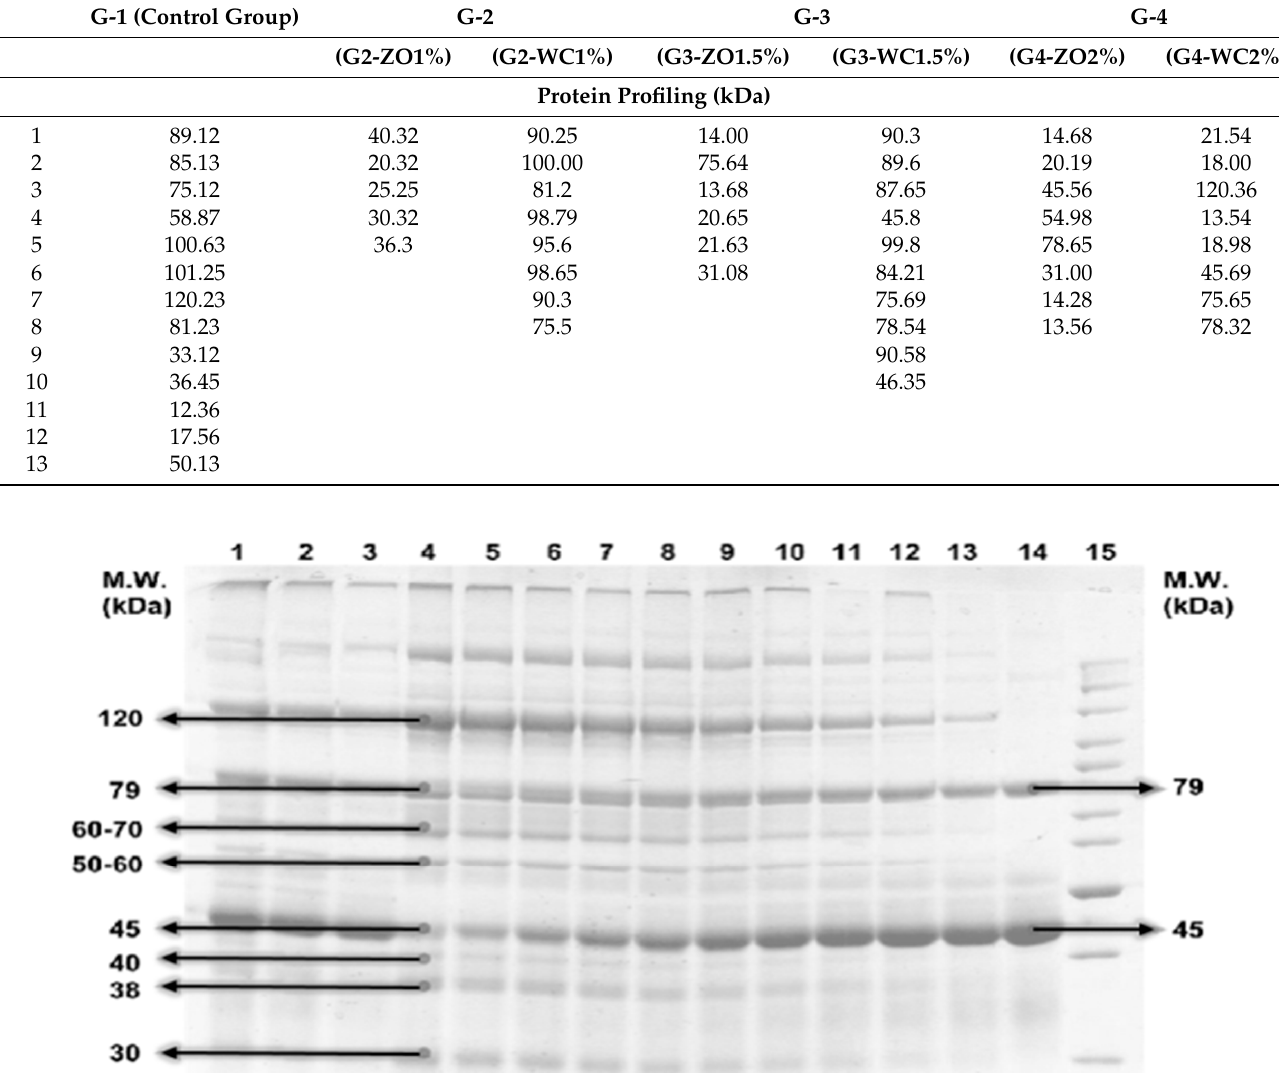
Table 4. Protein profiling of the groups.